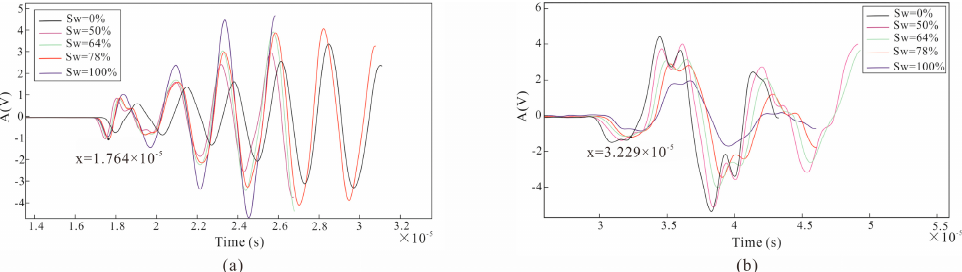
Figure 5. Waveform diagrams of P − wave ( a ) and S − wave ( b ) signal variation. Rock water saturation affects the size of rock physical parameters. The P − wave ve ‐ locity, S − wave velocity and resistivity of rock samples with water saturations of 0%, 50%, 64%, 78%, and 100% were statistically analyzed and fitted to the curves. The experimental results show that (1) with increasing water saturation, the P − wave velocity changed in three stages. When the water saturation was 0–23%, the P − wave velocity increased with increasing water saturation, and the slope was large. When the water saturation was 23– 78%, the P − wave velocity decreased with increasing water saturation. When the water saturation was between 78% and 100%, the P − wave velocity decreased with increasing water saturation (Figure 6a). (2) The S − wave velocity decreased linearly with increasing water saturation, and there was a negative correlation between the S − wave velocity and